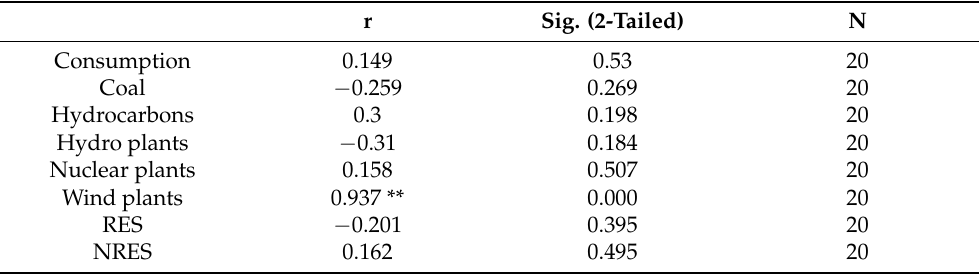
Table 5. Pearson correlation between GDP and electricity produced from different types of fuels, between Q1 2008 and Q4 2012. r Sig. (2-Tailed) N Consumption 0.149 0.53 20 Coal − 0.259 0.269 20 Hydrocarbons 0.3 0.198 20 Hydro plants − 0.31 0.184 Nuclear plants 0.158 Wind plants 0.937 ** 0.162